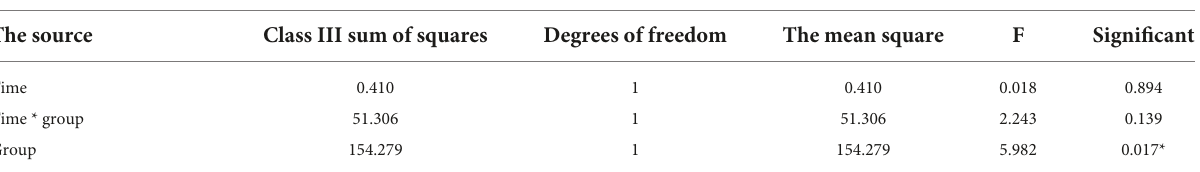
TABLE 3 Detection of intra- and intersubject